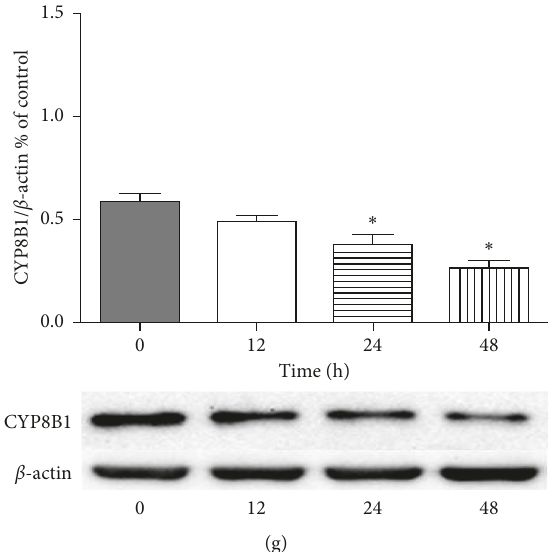
Figure 1: Cell viability and protein expression of FXR, MAFG, and CYP8B1 in each group by metformin treatment in HepG2 cells. (a) The effect of different doses of metformin (Met) on cell viability. Cells were treated with metformin for 96 hours, and the cell viability was measured by CCK8 assay. Results are mean ± SEM; ∗ p < 0 . 05 vs. control group. Protein contents were detected by western blotting and were quantified with Image J β -actin was used as a reference to verify equal loading of protein sample. The HepG2 cells were incubated with different concentrations of metformin (0, 0.5, 1, 1.5, and 2mM) for 24 h quantification of FXR (b), MAFG (c), and CYP8B1 (d). The HepG2 cells were incubated with 1 mM metformin for various durations (0, 12, 24, or 48 h), quantification of FXR (e), MAFG (f), and CYP8B1 (g). Results are mean ± SEM; ∗ p < 0 . 05 vs. control group. Table 1: Changes in fluid and food intake and body weight of rats in each group after STZ injection. Groups